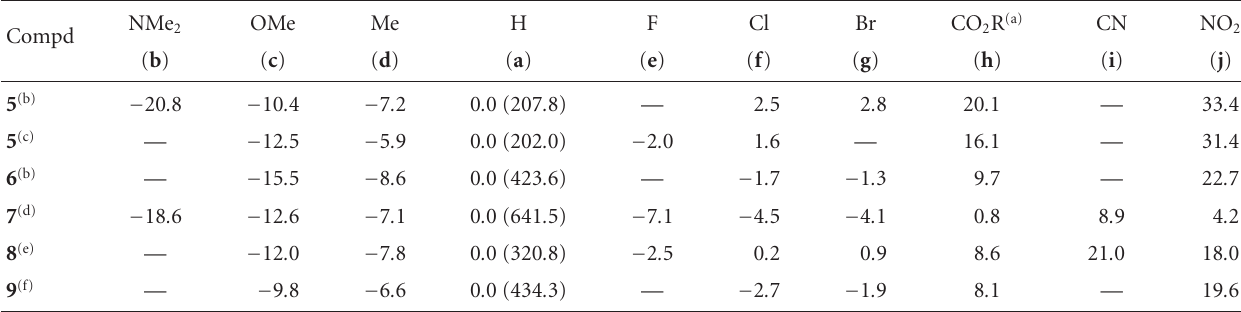
Table 6: Observed δ (Se) SCS reported for 5 – 9